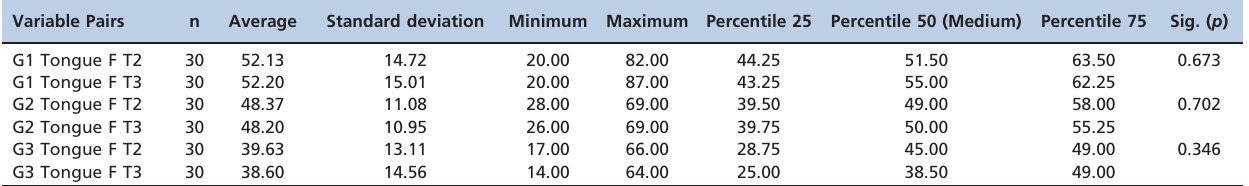
Table 4 - Wilcoxon Signed-Rank Test, which was used to verify possible differences among the moments of observation, (considered pairwise), for the variables of interest and by group studied. Variable Pairs